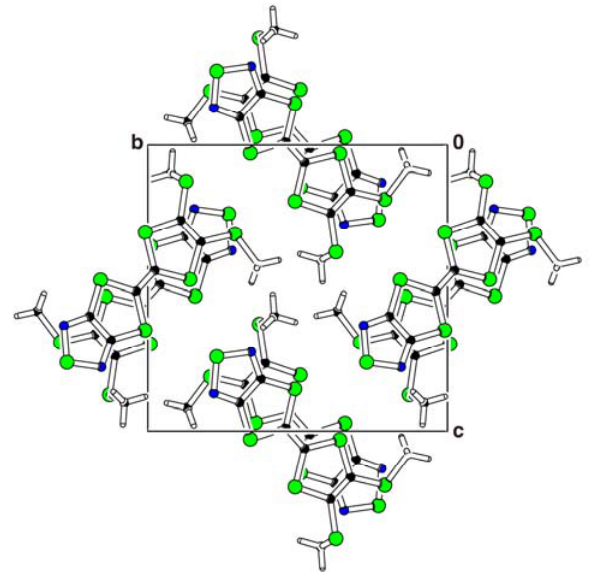
Figure 3. The packing diagram of 1 , viewed along the a